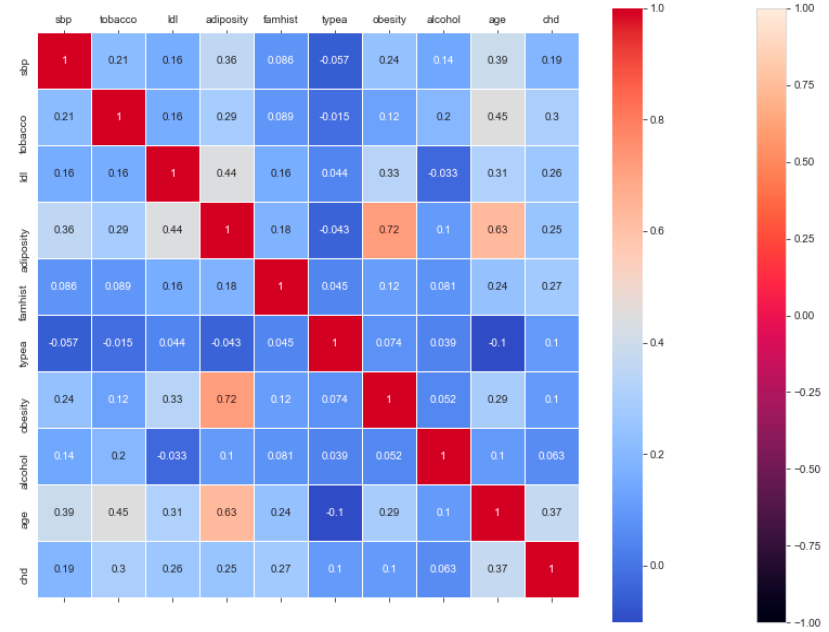
Figure 17. Correlation heatmap and classification accuracy of ML models to classify the “Cardiovascular-disease” data.